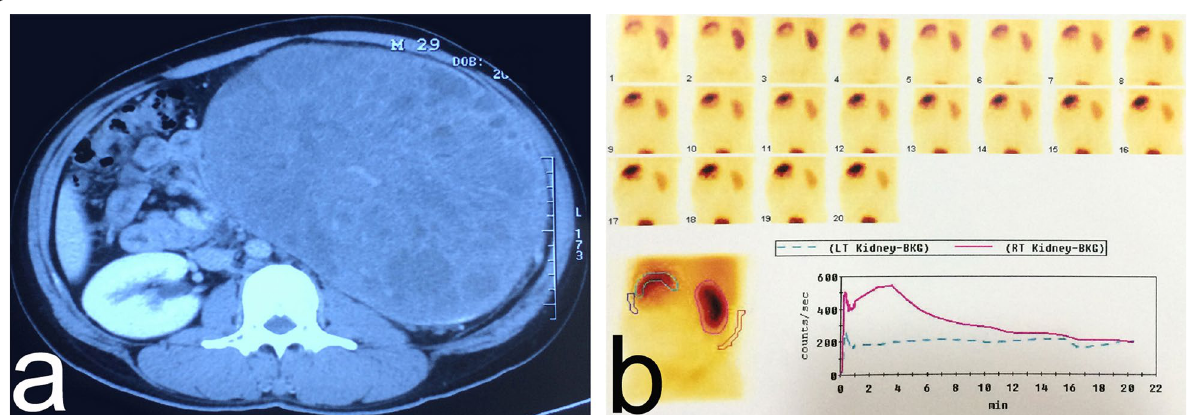
Fig. 1 Computed tomography and emission computed tomography of a 29-year-old man with a giant abdominal mass. a Computed tomography of the abdomen on May 6, 2015 before the surgery demonstrates a giant (22 cm 16 cm) solid mass in the left kidney without necrosis or calcifica- × tions. Heterogeneous enhancement can be seen during the arterial phase, and normal renal tissues are seriously squeezed. b Emission computed tomography reveals mild-to-moderate damage of the left kidney and normal function of the right